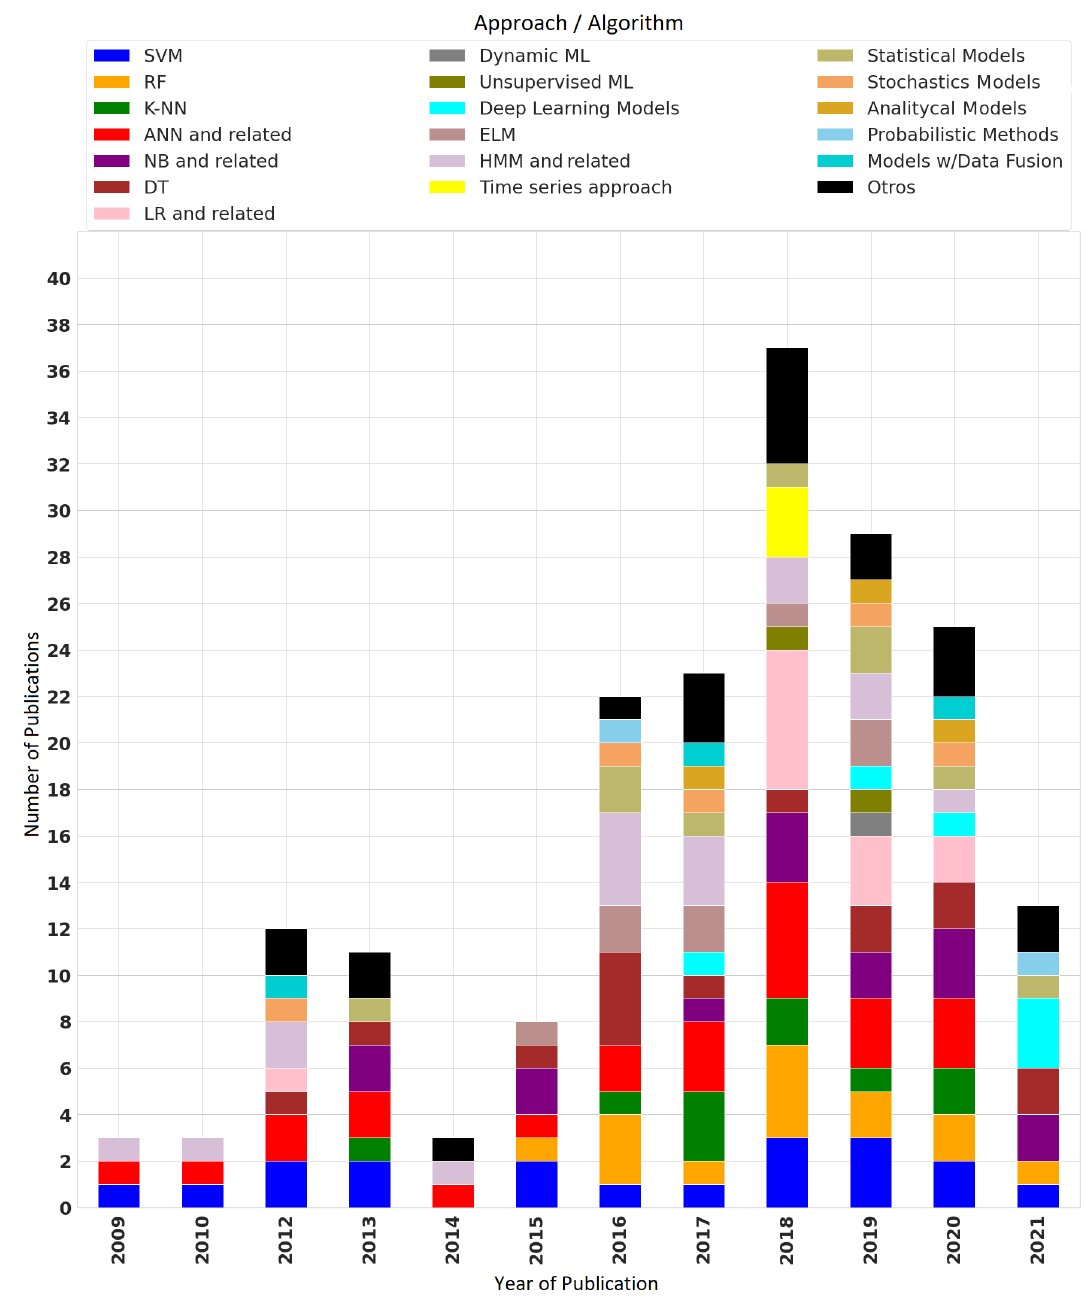
Figure 17. Occupational estimation approaches/algorithms over